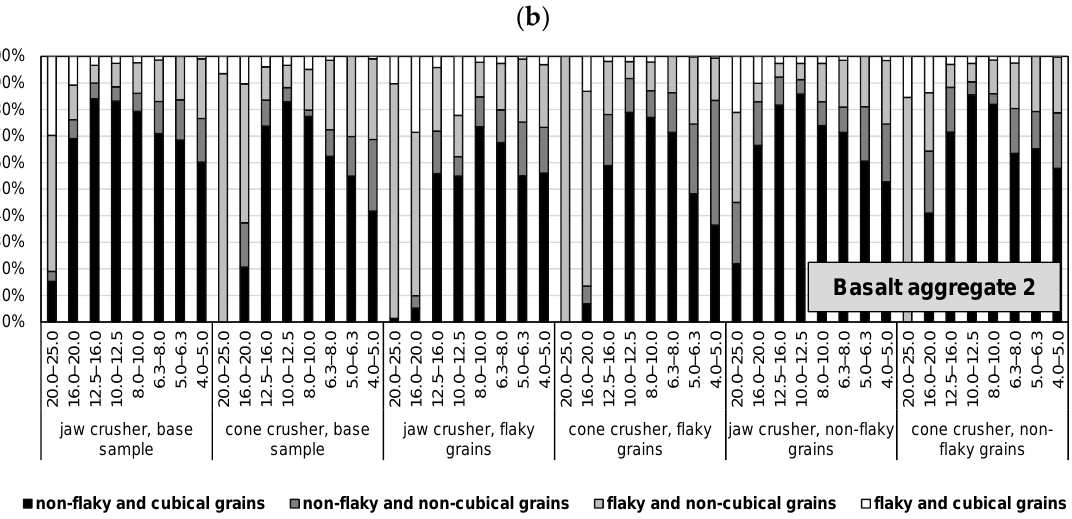
Figure 8. Characteristics of the distribution of grains with specific geometrical parameters in grain classes: ( a ) base samples; ( b ) basalt 1; ( c ) basalt 2.